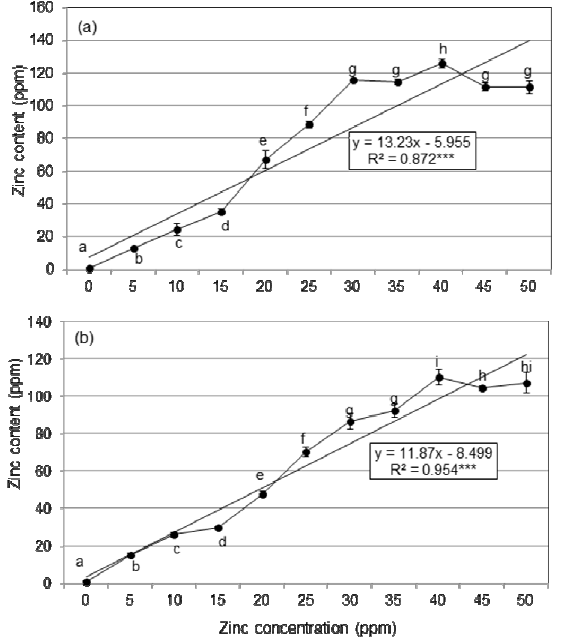
Fig. 4. Accumulation of Zinc in the stem (a) and leaf (b) of Talinum portulacifolium in nutrient solution. Error bar indicates ± standard error. Points followed by same letters are not significantly different according to DMRT (P>0.05). ***Significant at P <